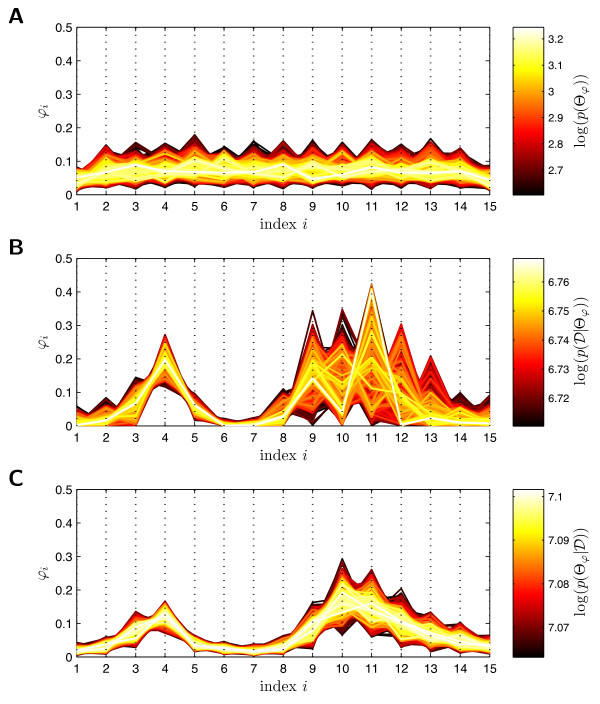
Visualization of 15-dimensional MCMC sample  from prior, conditional and posterior probability density. A. Plot of sample  drawn from prior probability density of Θφ(b3), p(Θφ). B. Plot of sample  drawn from conditional probability density of Θφ(b3), . C. Plot of sample  drawn from posterior probability density of Θφ(b3), . Each polyline represents hereby one point φk in the 15-dimensional density parameter space. The position of the vertex on the i-th dotted vertical line gives the value of the i-th density parameter. The color of the points indicates the logarithm of the unnormalized probability density of the data. Bright polylines (points φk) have a high posterior probability whereas dark polylines have a low posterior probability.